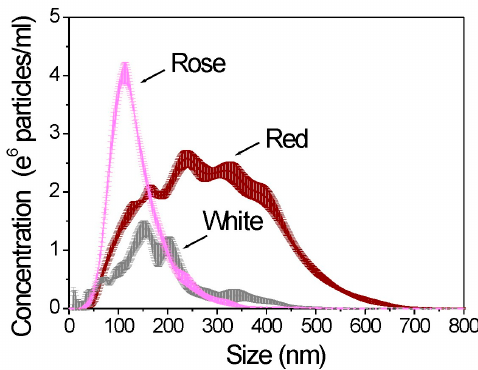
Figure 1. Particle size distributions of white, rosé, and red wine samples.